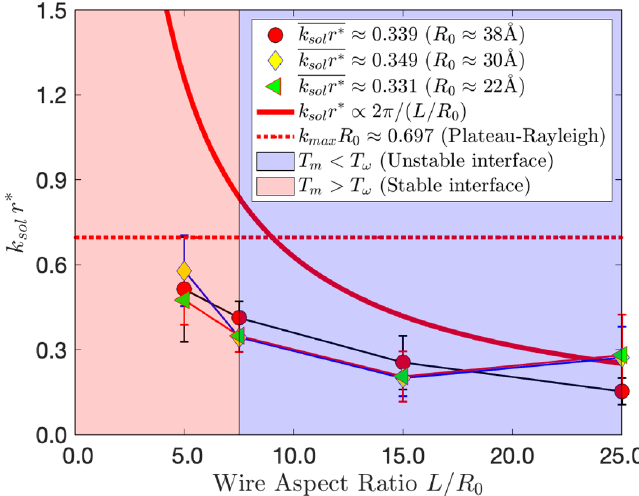
Figure 4. This figure shows how the wire aspect ratio affects the fastest growing modes. A thick red line plots 2 π/( L / R 0 ) , which we assume is proportional to k sol r ∗ . The light shaded area shows the region where the interface is stable at temperatures close to T m (radial mode), whereas the darker shaded region shows where the interface is expected to be unstable (instability mode).